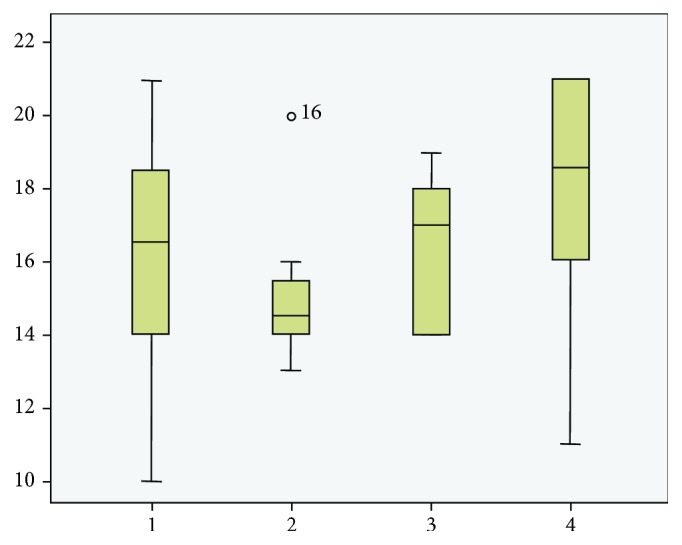
A histogram showing the histological scores in each group. 1 = SC; 2 = PRP; 3 = SC+PRP; 4 = ET. SC: stem cell; PRP: platelet-rich plasma; ET: eccentric training.